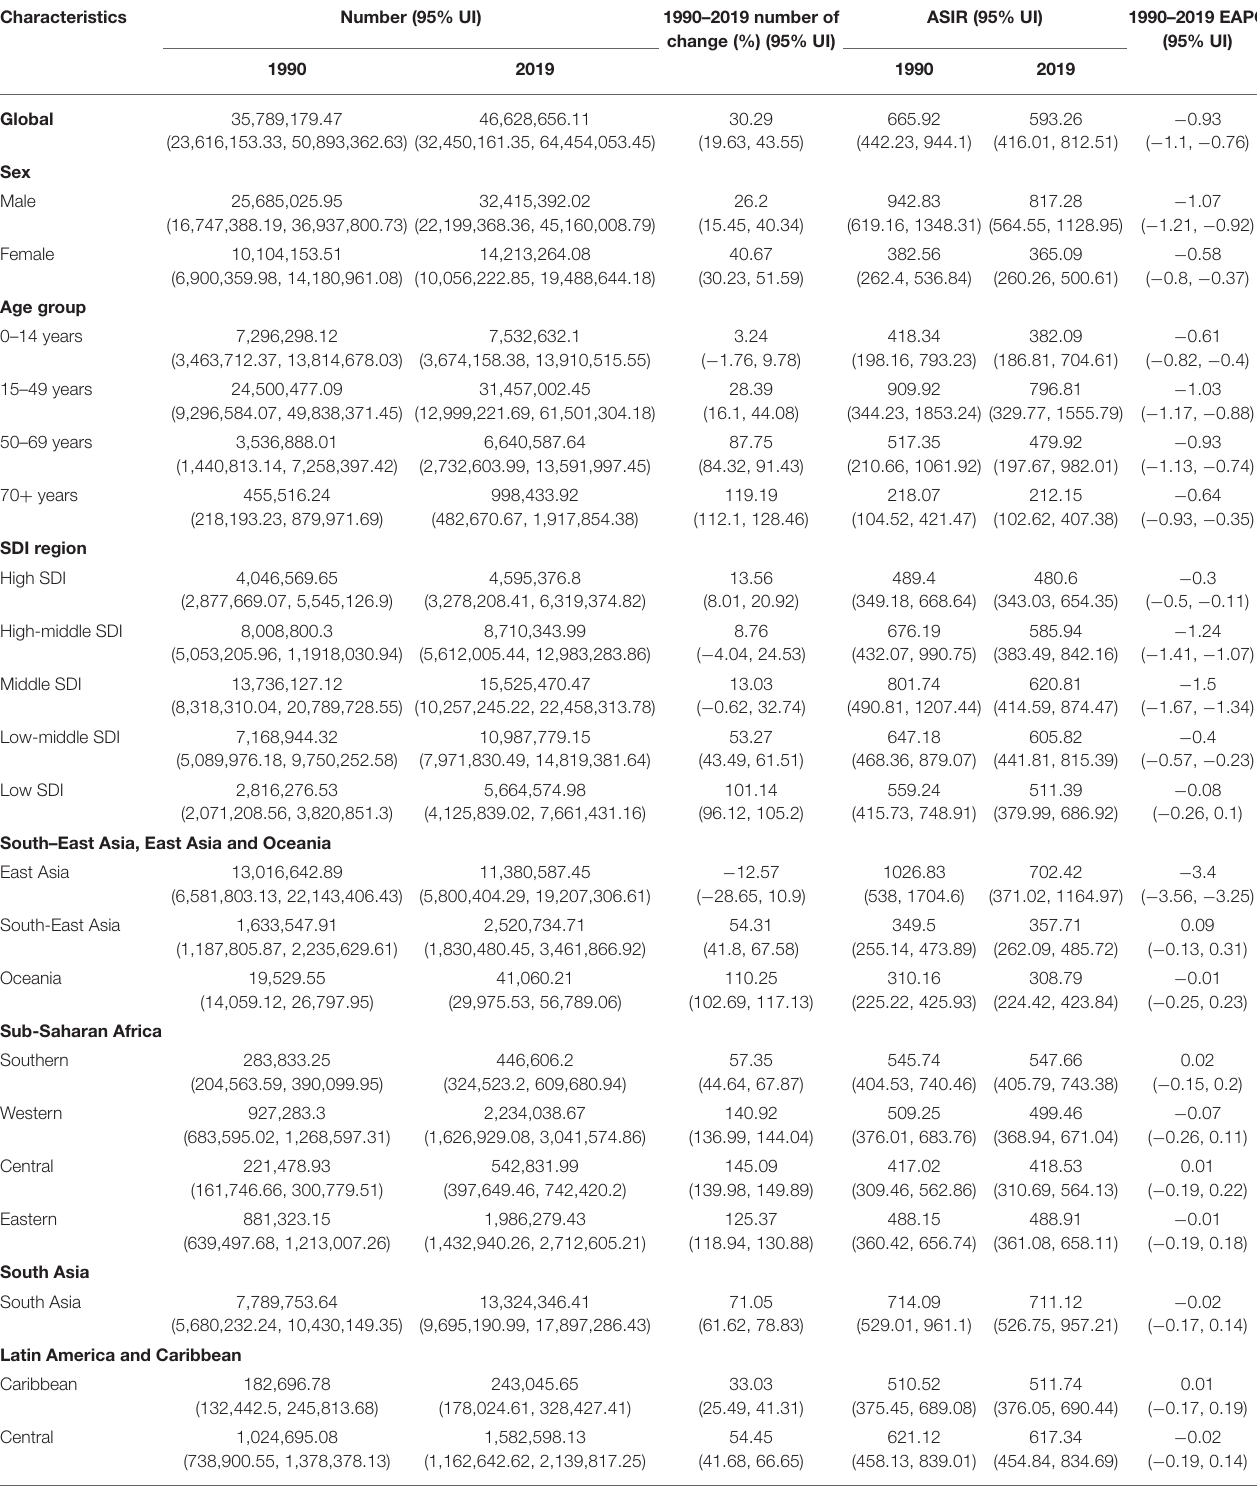
TABLE 1 | Estimated number and age-standardized rate (per 100,000 persons) of incidence and corresponding trend for IOFBs from 1990 to 2019 by sex, age group, SDI, and GBD regions.